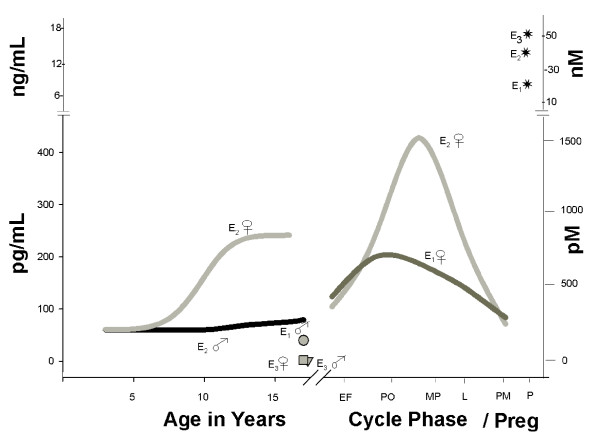
Levels of physiologic estrogens during different life stages in females compared to males. These data were graphed from information summarized in a textbook [62], and span concentrations over 2 orders of magnitude. Levels over time and different stages are shown by lines, and point values are shown as symbols, all labeled directly on the graph. Cycle phases are labeled on the timeline as EF (early follicular), PO (preovulatory), MP (mid cycle-peak), L (luteal), PM (post menopausal), and P (pregnant, peak levels). The levels of the estrogens estrone, estradiol, and estriol (E1, E2, and E3, respectively) are shown for females (♀) and males (♂)